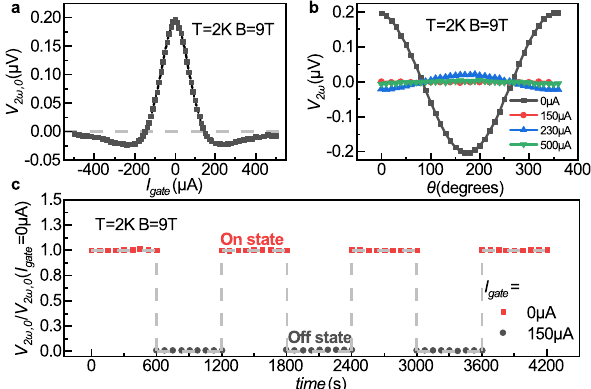
Fig. 3 Operation of an MnPS 3 magnon valve. a V 2 ω ,0 versus DC gate current I gate at B = 9 T and temperature of 2 K. b V 2 ω as a function of angle θ of the external magnetic fi eld at four different I gate values. c Operation of the MnPS 3 magnon valve with I gate toggles repeatedly between 0 μ A (On state) and 150 μ A (Off